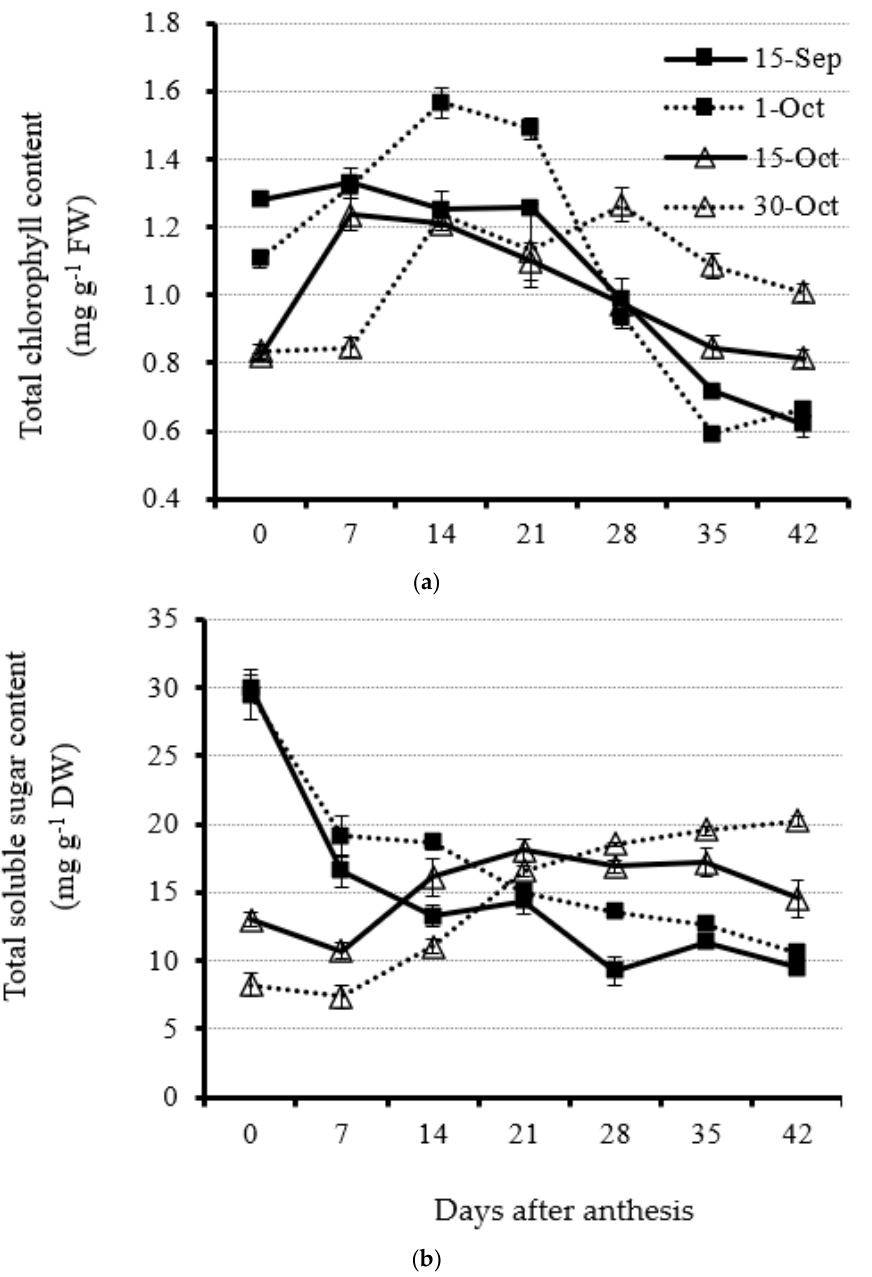
Figure 3. Leaf total chlorophyll ( a ) and total carbohydrate ( b ) content accumulation from anthesis with a 7 d interval under four planting dates—early, optimal, late, and very late (15 September, 1 October, 15 October, and 30 October, respectively)—in 2020. Bars of each value are standard error.